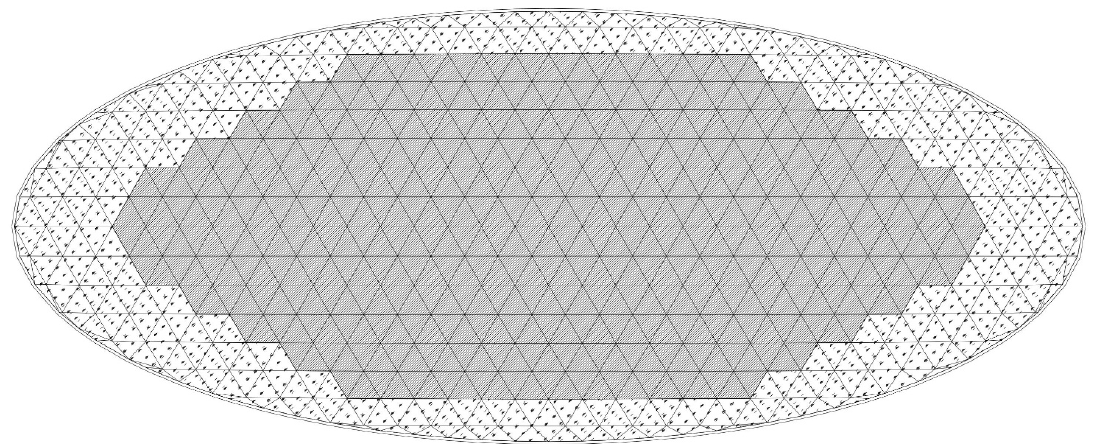
Figure 2. Roof plan.